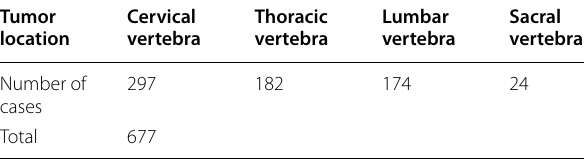
Table 2 Number of cases corresponding to tumor